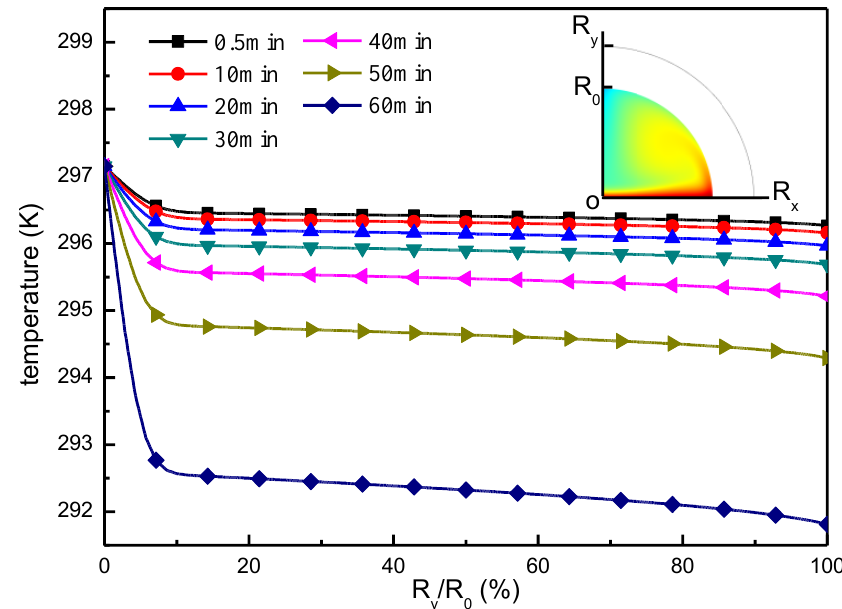
Figure 9. Temperature distribution on the centerline of the droplet.